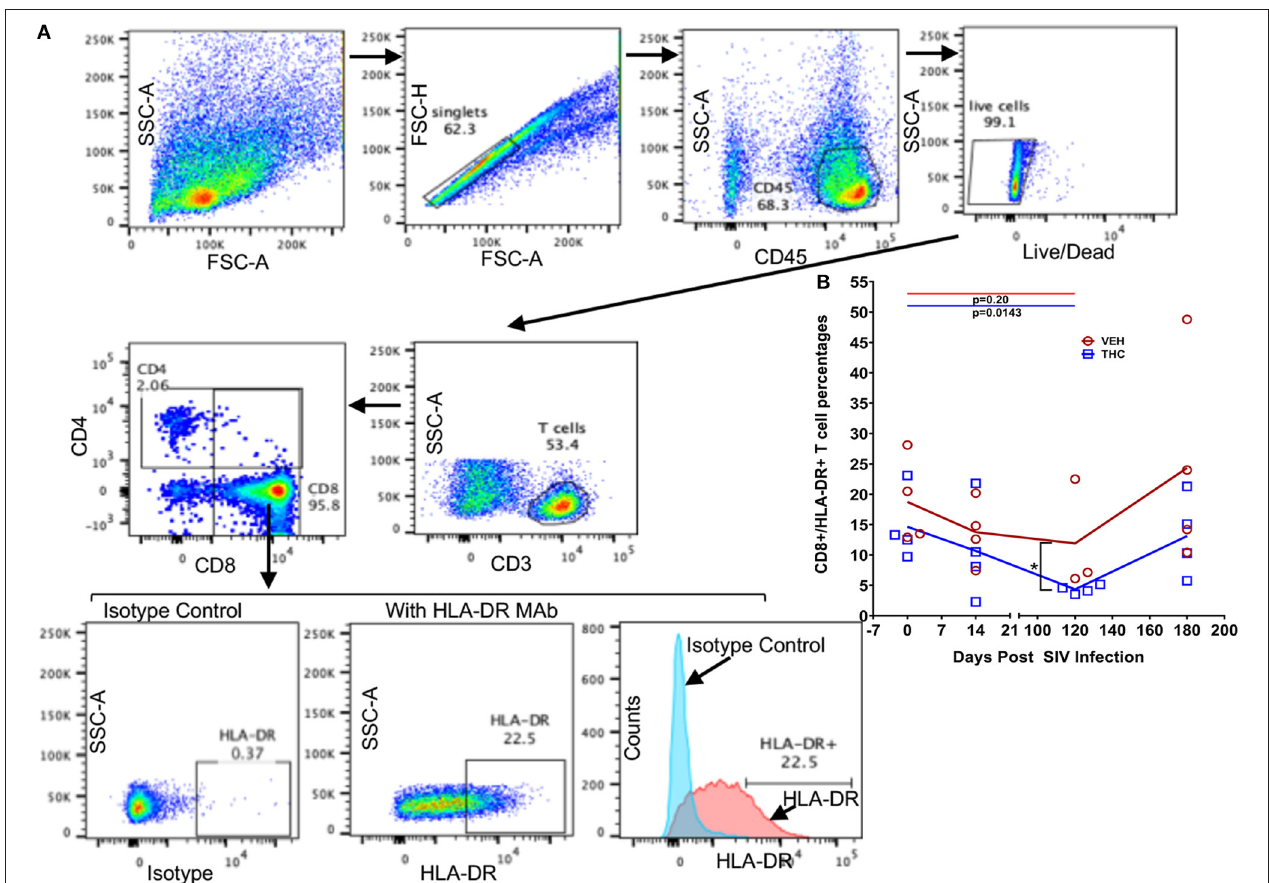
FIGURE 9 | Delta-9-tetrahydrocannabinol ( 1 9 -THC) administration inhibited HLA-DR expression in intestinal CD8 + T cells after SIV infection. Gating strategy for HLA-DR expression from a representative VEH/SIV rhesus macaque (A) . Cells were gated first on singlets, CD45 (lymphocyte common antigen), followed by live cells, and then on CD3 + T cells. T-cells were further gated on CD3 + CD4 + and CD3 + CD8 + T cell subsets. The percentages of total HLA-DR expression in CD8 + T cells are shown in the bottom row where the positive HLA-DR expression was compared to the isotype control both in the dot plots and histograms. (B) THC/SIV rhesus macaques showed reduced percentage of CD8 + T cells expressing the late activation marker HLA-DR at 120 days post SIV compared to VEH/SIV rhesus macaques. Note that data from only three VEH/SIV rhesus macaques were available for the 120 days post-infection time point as LPL yields from one animal were insufficient for flow cytometry. Open red circles- VEH/SIV, Open blue squares- THC/SIV. Horizontal red and blue lines with P -values denote comparisons between time points within the VEH/SIV and THC/SIV groups, respectively. Left black brackets with an asterisk indicate statistical significance ( p = 0.0286) between the VEH/SIV and THC/SIV groups for a given time point. Connecting blue and red lines (B) denote mean values of the respective population in the THC/SIV and VEH/SIV groups, respectively. Flow cytometry analysis to determine the effect of 1 9 -THC on HLA-DR expression in intestinal CD8 + T cells of SIV-infected rhesus macaques was performed once with three to four individual animals as biological replicates per group. Flow cytometry data were analyzed using linear mixed models with immune-marker outcomes being dependent variables, and treatment status (VEH vs. 1 9 -THC) and days since the start of treatment (0, 14, 120, 180) being independent variables with fixed effects. Differences between two time points were analyzed using the Mann-Whitney U -test employing the Prism v5 software (GraphPad software). A p -value of ≤ 0.05 was considered